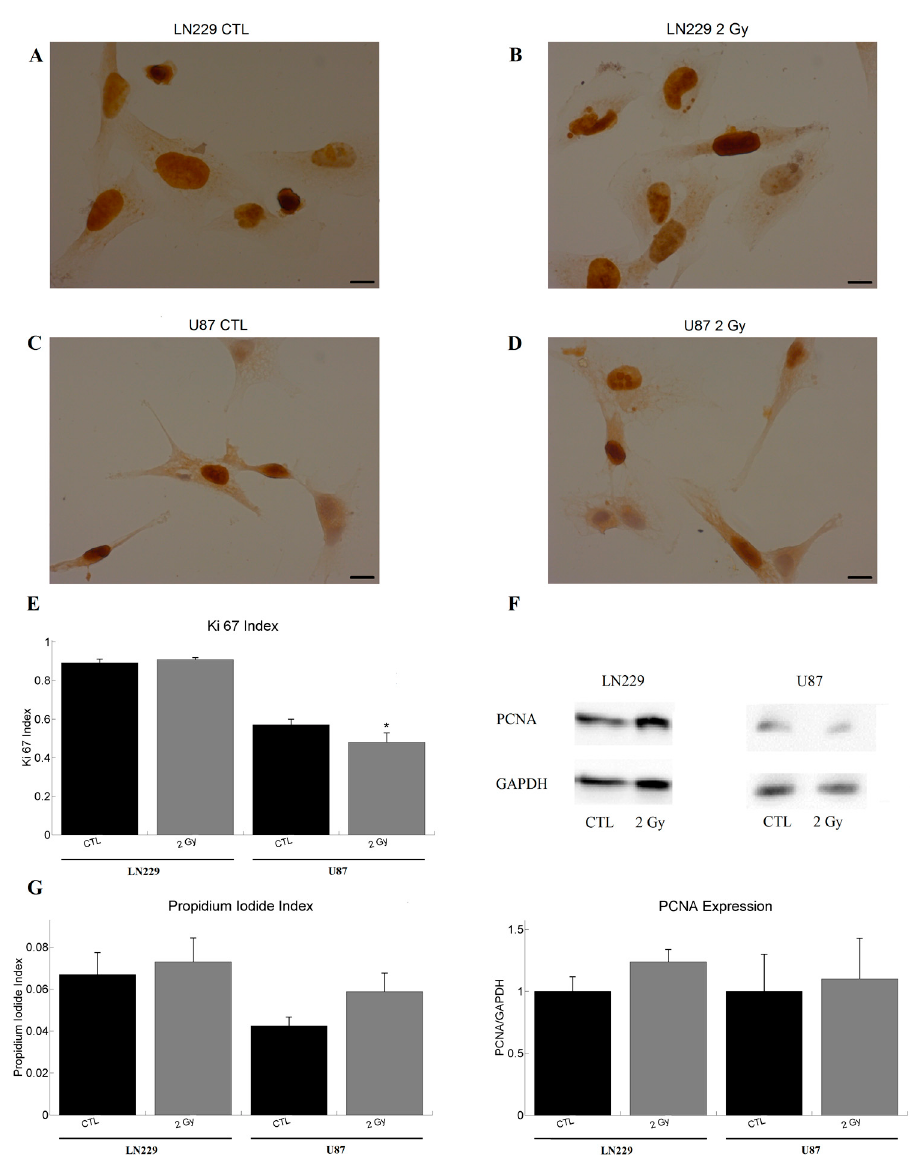
Figure 1. Influence of irradiation on cell division and death. ( A , B ) representative images of the Ki67 staining of LN229 cells with and without irradiation with 2 Gy. Most of the cells were found to be proliferating; ( C , D ) depicts a representative sample of the Ki67 staining of U87 cells with and without irradiation with 2 Gy. One can observe a slightly decreased number of Ki67 positive cells compared to the control group. LN229 ( A , B ) cells are more proliferative than U87 ( C , D ) cells; ( E ) illustrates the respective Ki67 index (Ki67 positive cells/cell number) of LN229 (sample size: n CTL = 20; n 2Gy = 16) and U87 ( n CTL = 21; n 2Gy = 27) cells before and after irradiation. Irradiation decreased the proliferation rate of U87 only; ( F ) shows the PCNA expression of LN229 ( n CTL = 5; n 2Gy = 5) and U87 ( n CTL = 4; n 2Gy = 4) cells, normalized to the control groups and a representative blot with GAPDH at 37 kDa and PCNA at 36 kDa. No significant effects were observed; ( G ) visualizes the ratio of propidium iodide positive (dead) cells to the total number of cells for LN229 ( n CTL = 10; n 2Gy = 10) and U87 ( n CTL = 10; n 2Gy = 10). No significant effect was observed. The graphs show the mean value together with the standard error of the mean (sem). Statistics was performed using t -test and significance was chosen for p < 0.05. The asterisk denotes significant results regarding the control measurement of the same cell line. Scale bar corresponds to 10 µm.